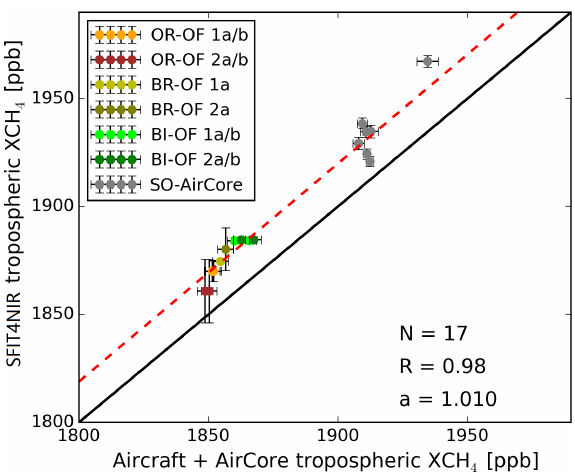
Figure 12. The scatter plots of X CH between the SFIT4NIR and 4 the IMECC aircraft measurements together with the AirCore mea- surements for the tropospheric components. The black line is the one-to-one line and the dashed red line is the regression line with the intercept to zero ( y = a · x ). N is the co-located measurement number, R is the correlation coefficient and a is the